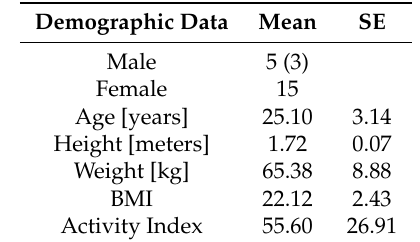
Table 1. Demographic data (brackets indicate the number of male participants at the end of the study).